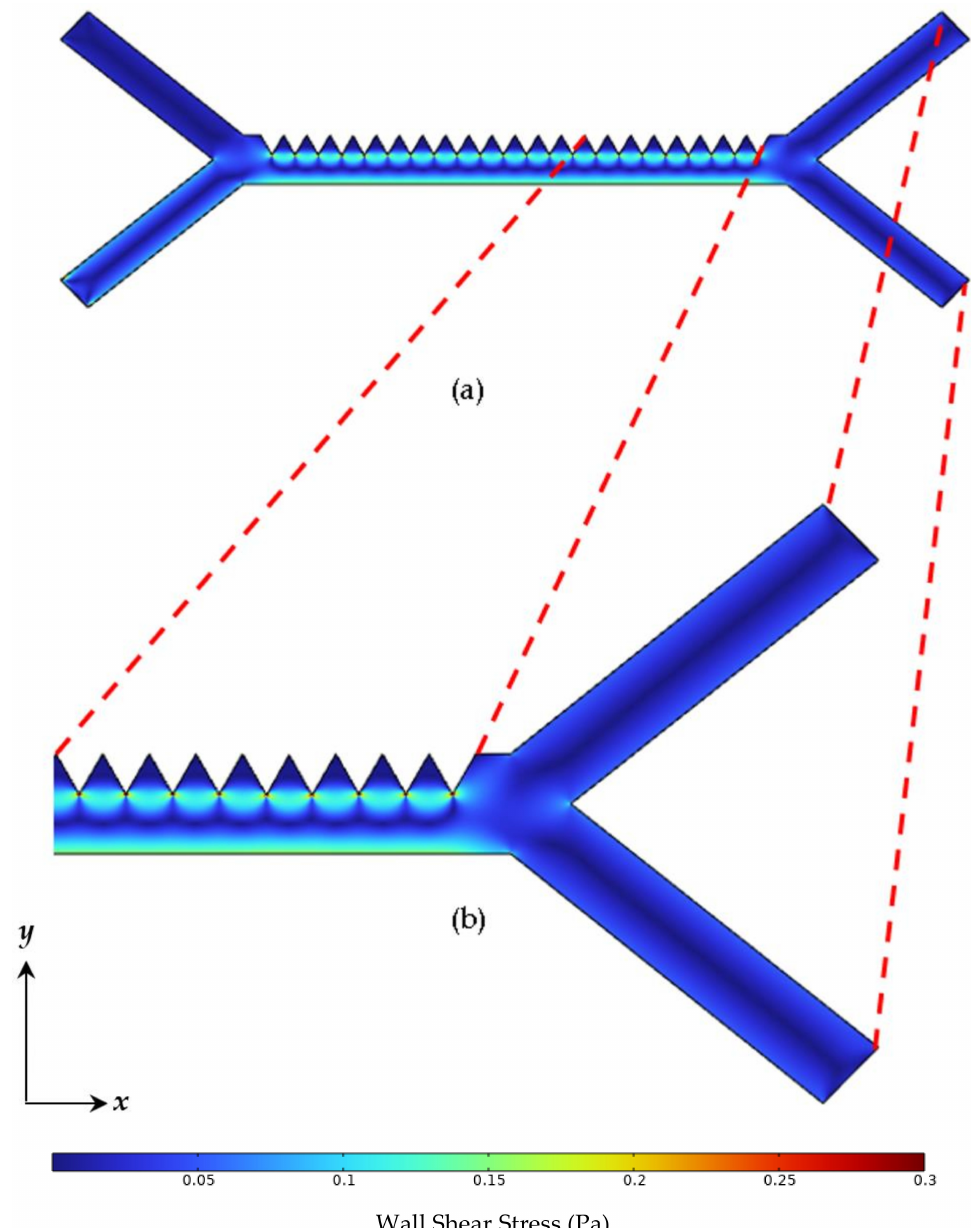
Figure 13. Contour of wall shear stress: ( a ) Full view of the microchannel and ( b ) zoomed in view of the microchannel and electrode region on the right end of the